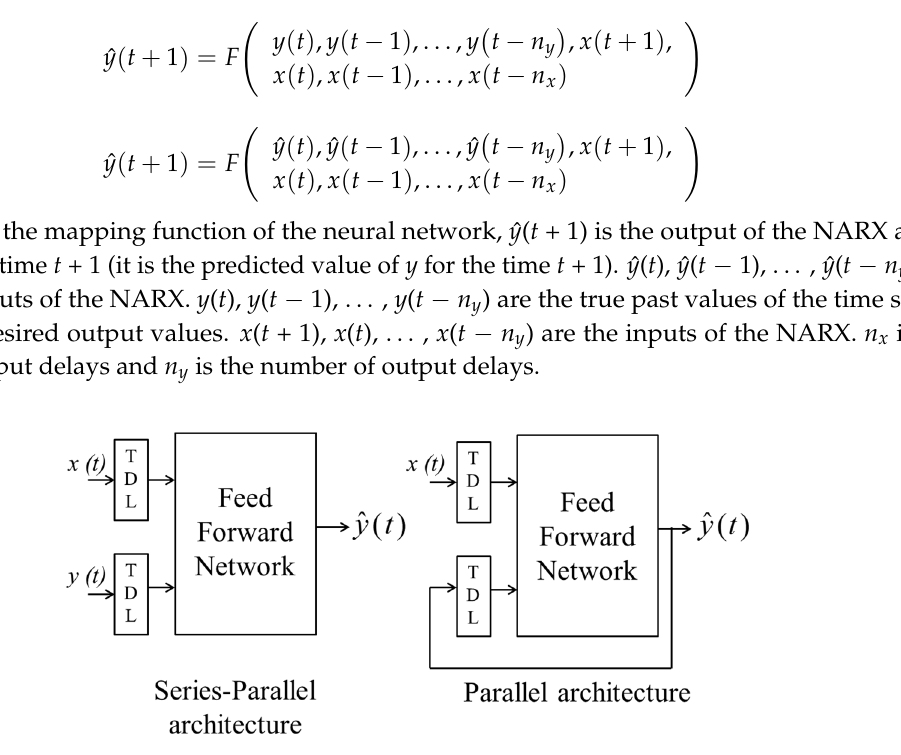
Figure 1. Architectures of the NARX neural network.